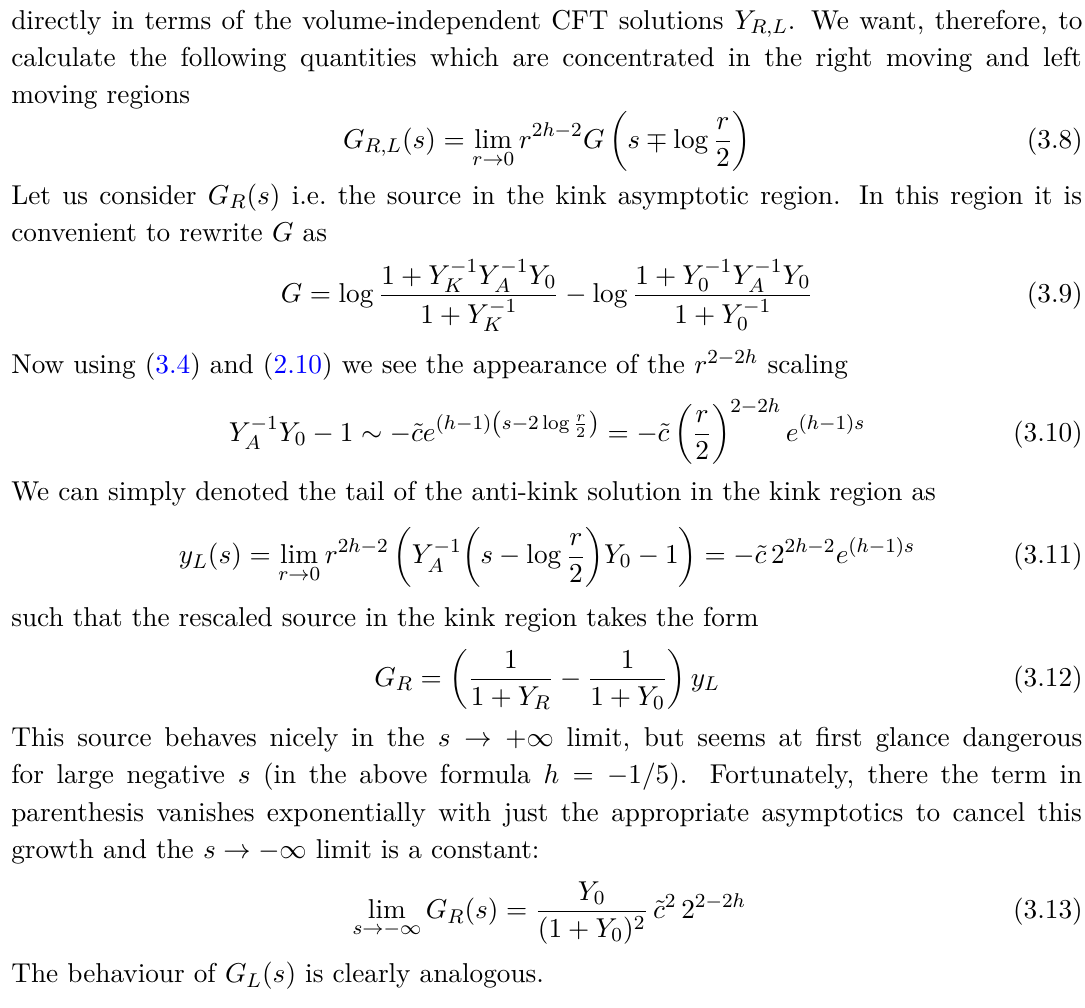
= δY − 1 is of order 10 − 7 and is not as